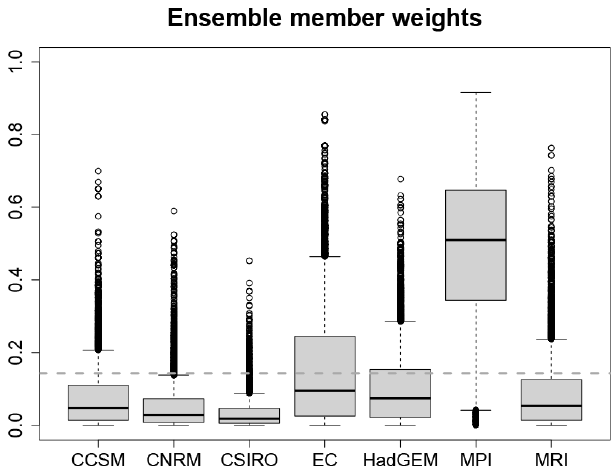
Figure 8. Posterior ensemble member weights ( λ ) of the recon- struction. Prior weights (mean of λ ) are denoted by the dashed